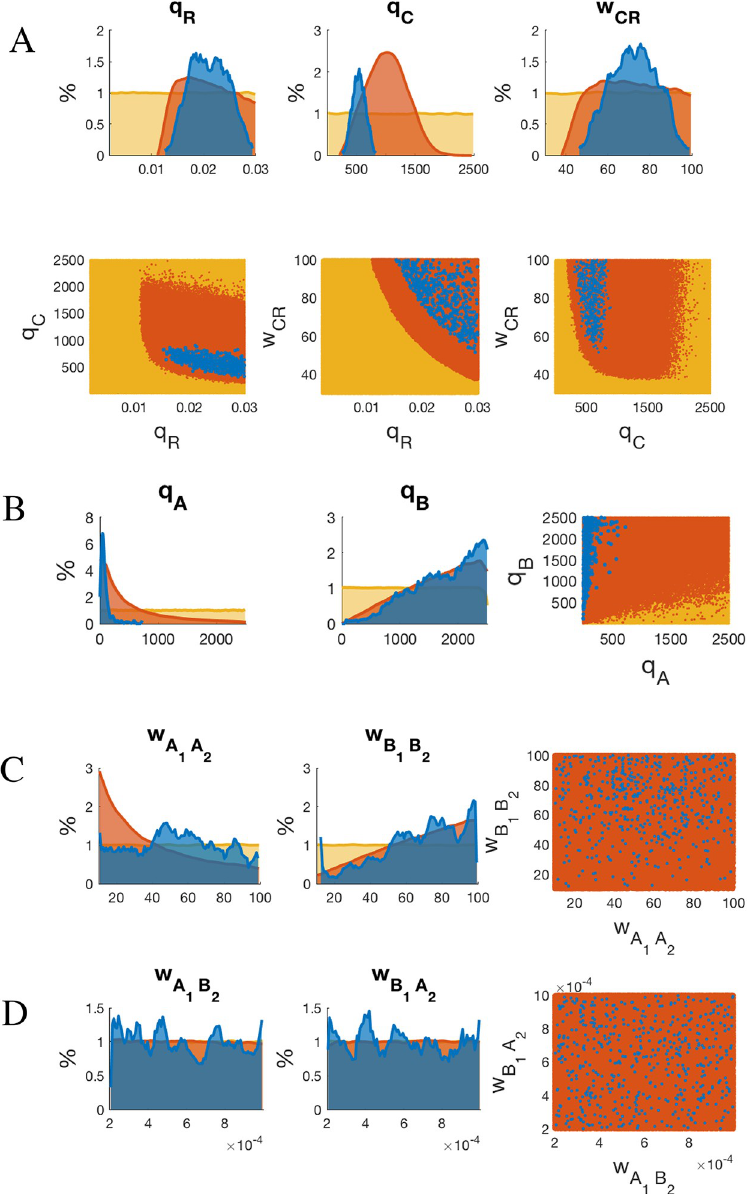
Fig 4. Analysis of the parameter fitting. (A): Top row: sample histograms of the parameters q R , q C and w C . Yellow represents the entire sample population (uniform distribution), orange the samples for which the distances F C and F H are below the threshold τ = 0.05, and blue the samples fitting the entire truth table. Lower row: correlation between pairs of parameters in the 3 cases (same color code). For all 3 parameters, the orange histograms are no longer uniform, but restricted to smaller ranges. Such ranges concentrate even further for the feasible samples (blue), in particular the interval for q C becomes quite tight. The correlation plots indicate that the boundaries between parameters subsets are well-defined and sharp. In particular, both q and w have to be big enough in order to fulfill R CR the entire truth table (i.e., blue points are in the top right corner). Notice how instead the binding affinity q C cannot be big. (B): Sample histograms of the parameters q and q , and their correlation. Notice the sharp difference in the two A B histograms: q � q for feasible samples. (C): Sample histograms of the interaction coefficients w and w . The A B A 1 A 2 B 1 B 2 two orange histograms have a neat difference, which is however only partially reflected in the feasible samples (blue). (D): Sample histograms of the interaction coefficients w and w . No clear trend appears. A 1 B 2 B 1 A 2